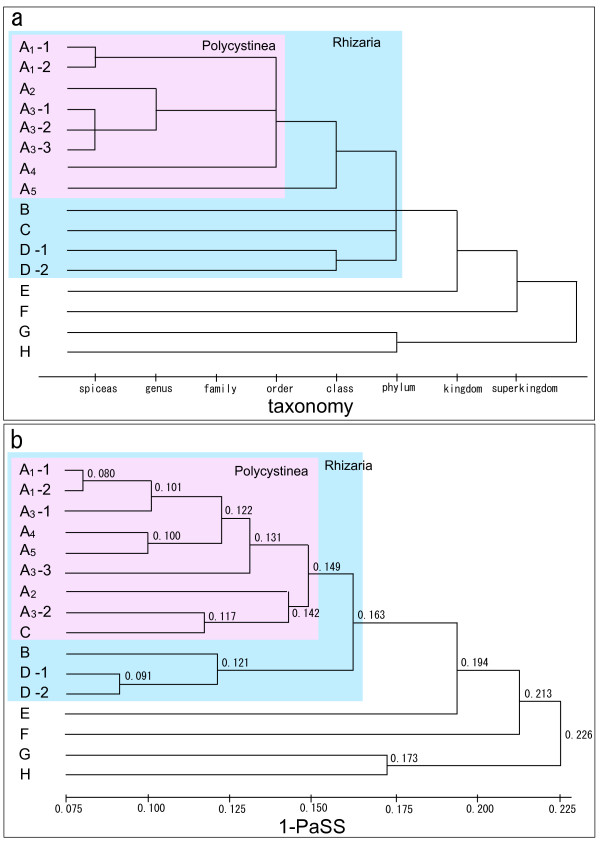
Phylogenetic trees of single-celled organisms. a) Phenotype based dendrogram. Taxonomical classification (abscissa) is followed after that supported by Pub Med [24]. b) Genome distance-based dendrogram. Genome distance is defined as (1-PaSS). The group average method (GAM) was used [14]. Haeckel's Radiolaria is A, B, C.